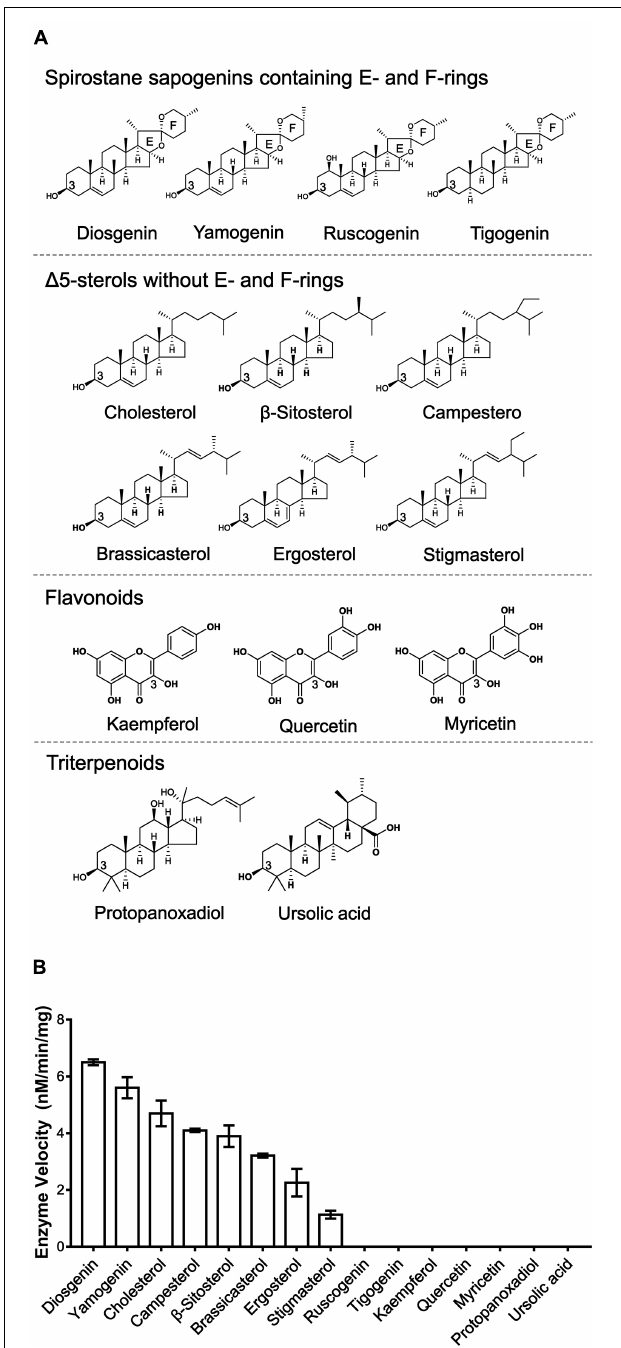
FIGURE 4 | Enzyme activities of TfS3GT2 with different types of aglycones. (A) Chemical structures of four types of the alycones tested. (B) Enzyme activities of TfS3GT2 on four types of the aglycones with UDP-glucose as a sugar donor. In the in vitro enzyme assays, saturate concentrations of the acceptors and the UDP-glucose donor were utilized (see the section “Materials and Methods”). The assays were carried out for 20 min. The enzyme activities of TfS3GT2 on various alycones were quantified based on the mole numbers of the aglycones consumed by the enzyme, relative to the control reactions which do not include TfS3GT2. Values represent the means ± SD from three independent